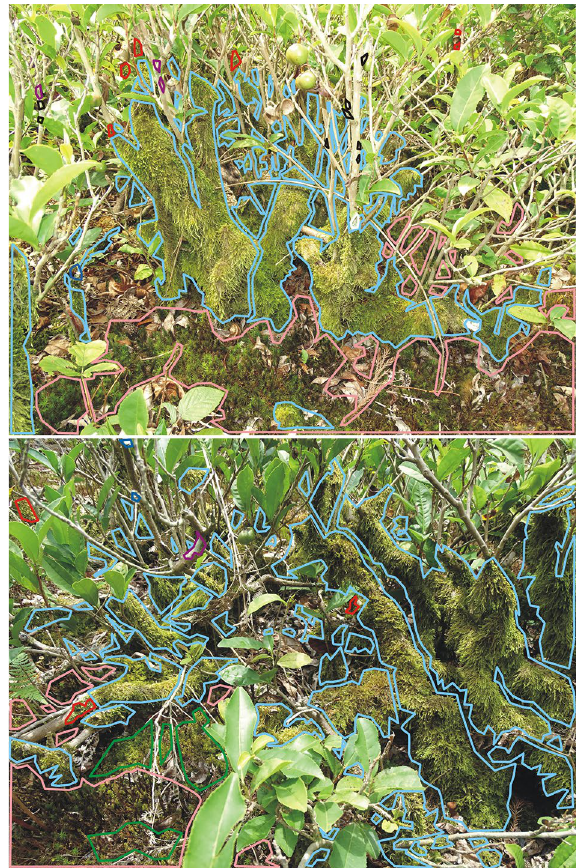
Figure 7. Distribution patterns of lichens and mosses—Ozurgeti plantation (photos by R. Piwowarczyk, 29 July 2018). Explanation: Bacidia laurocerasi —black, Fellhanera —dark purple, Hypnum cupressiforme —blue, Parmotrema perlatum —dark blue, Plagomnium affine —dark green, Polytrichum longisetum —pink, Punctelia subrudecta —white, Radula complanata